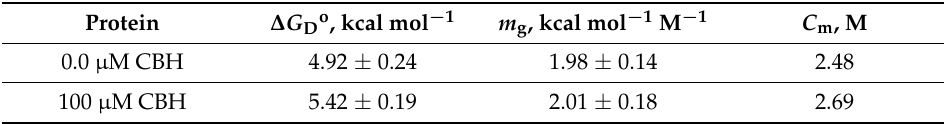
Table 3. Thermodynamic parameters associated with GdmCl-induced denaturation of HSA in the presence and absence of CBH.